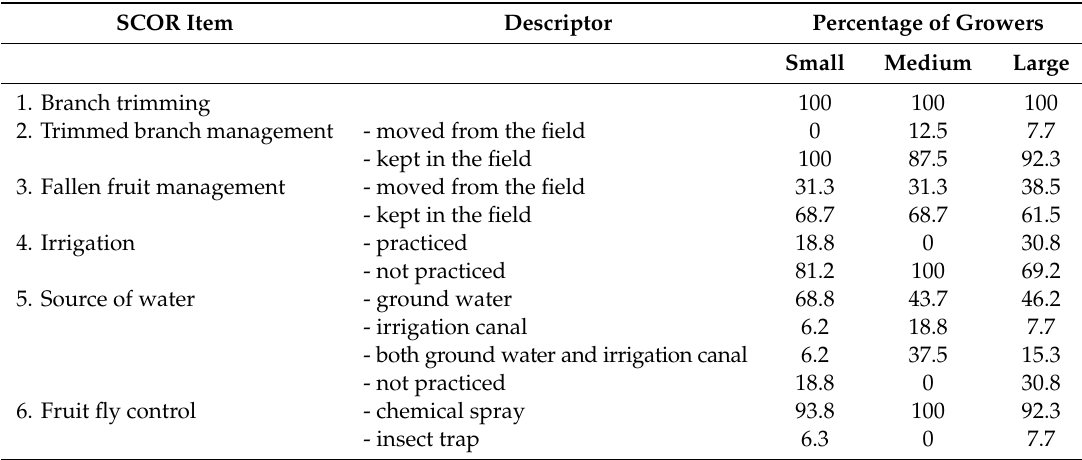
Table 4. Practices in mango production fields with di ff erent farm sizes followed by the supply chain operation reference (SCOR)